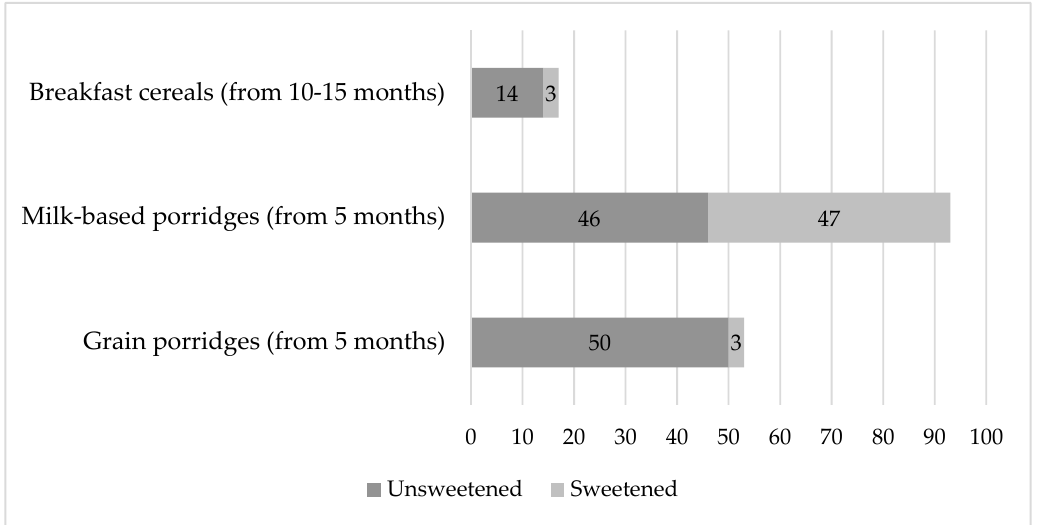
Figure 2. Proportion of sweetened commercial cereals by category.